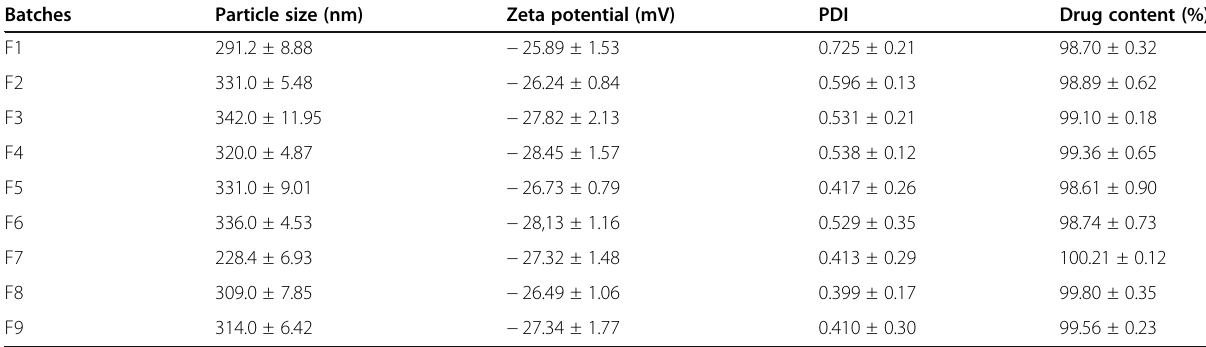
Table 2 Characterization of designed batches F1 to F9 Batches